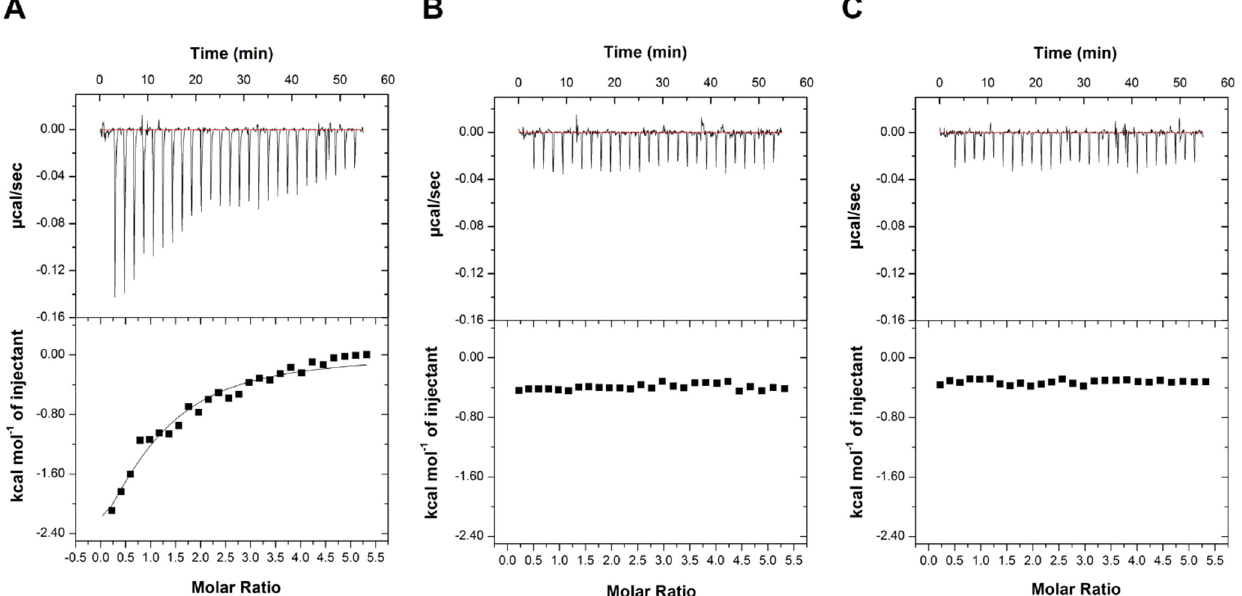
Figure 4. ITC binding studies on Gal-3 CRD . ( A ) Titration with SeDG and ( B ) with unsym(Se) in ( C ) the titration of buffer (negative control) is shown. The top panels of the graphs correspond to the injections while the bottom panels correspond to the integrations of the peaks according to the molar ratio of the tested molecules.